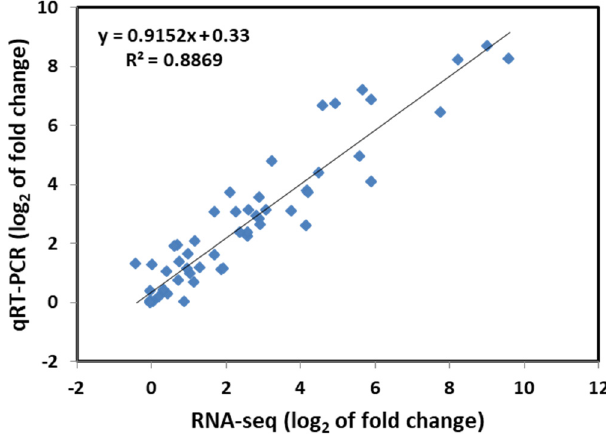
Figure 1. Correlation analysis of the relative expression of randomly selected genes obtained from qRT-PCR and RNA-seq data. The log 2 ratio values of relative expression are between non-low-temperature stress-treated and low-temperature-treated samples.